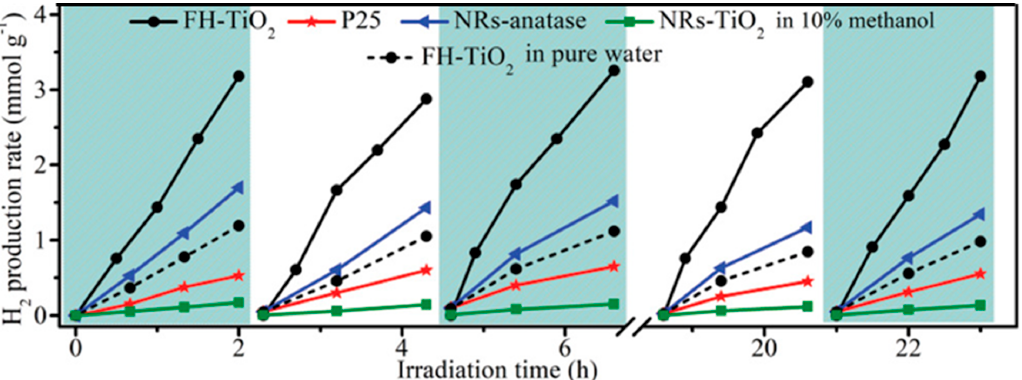
Figure 6. Photocatalytic hydrogen production cycle experiment. One wt% Pt as a cocatalyst was loaded on FH-TiO 2 , P25, NRs-anatase, and NRs-TiO 2 . Reprinted with permission from